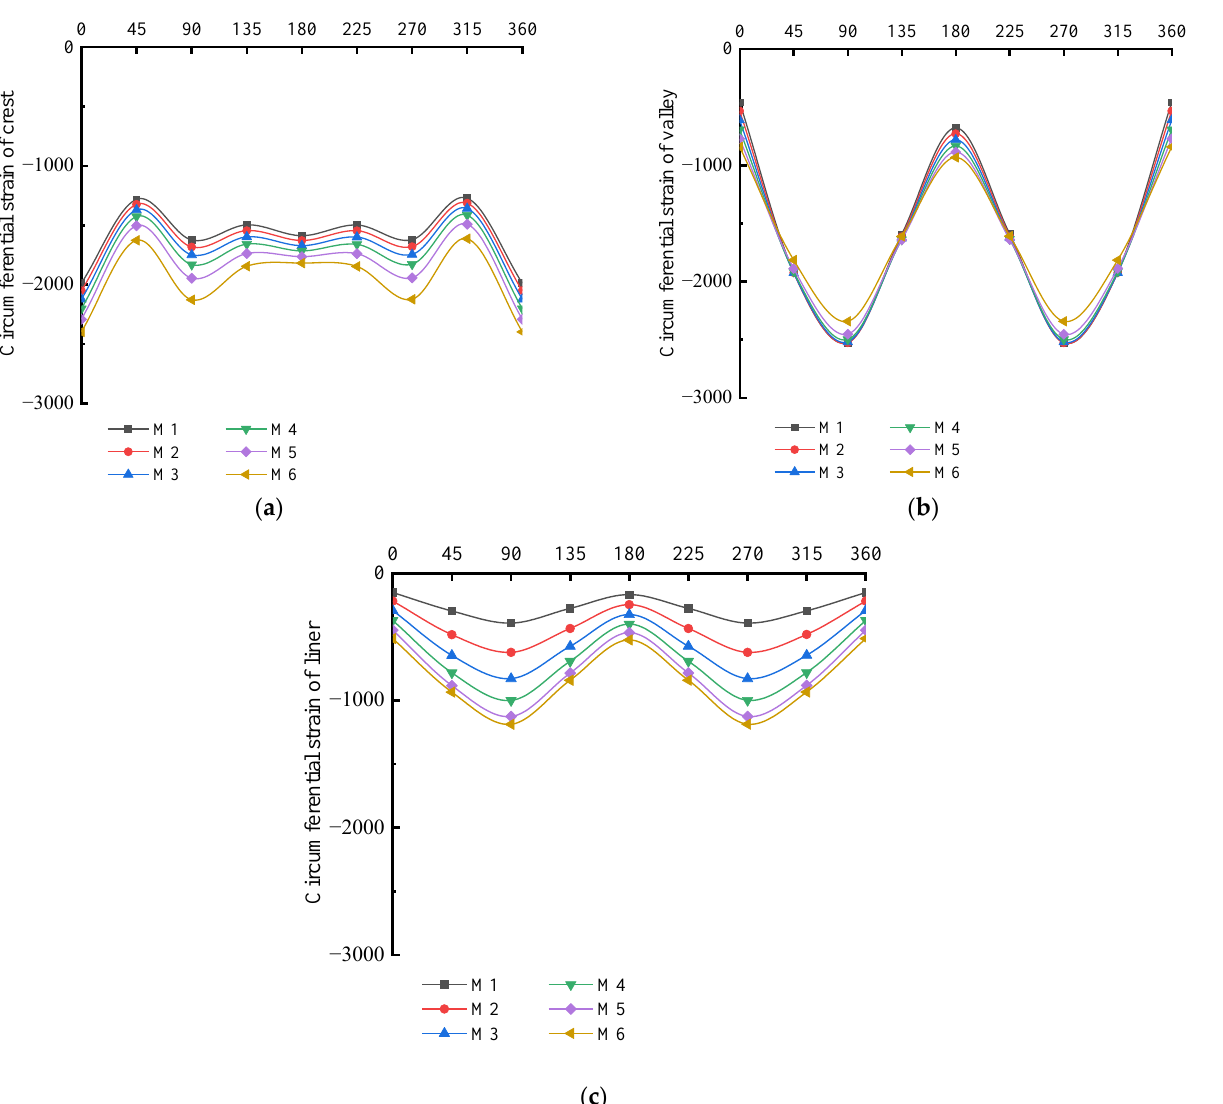
Figure 19. Circumferential strain of interior wall.